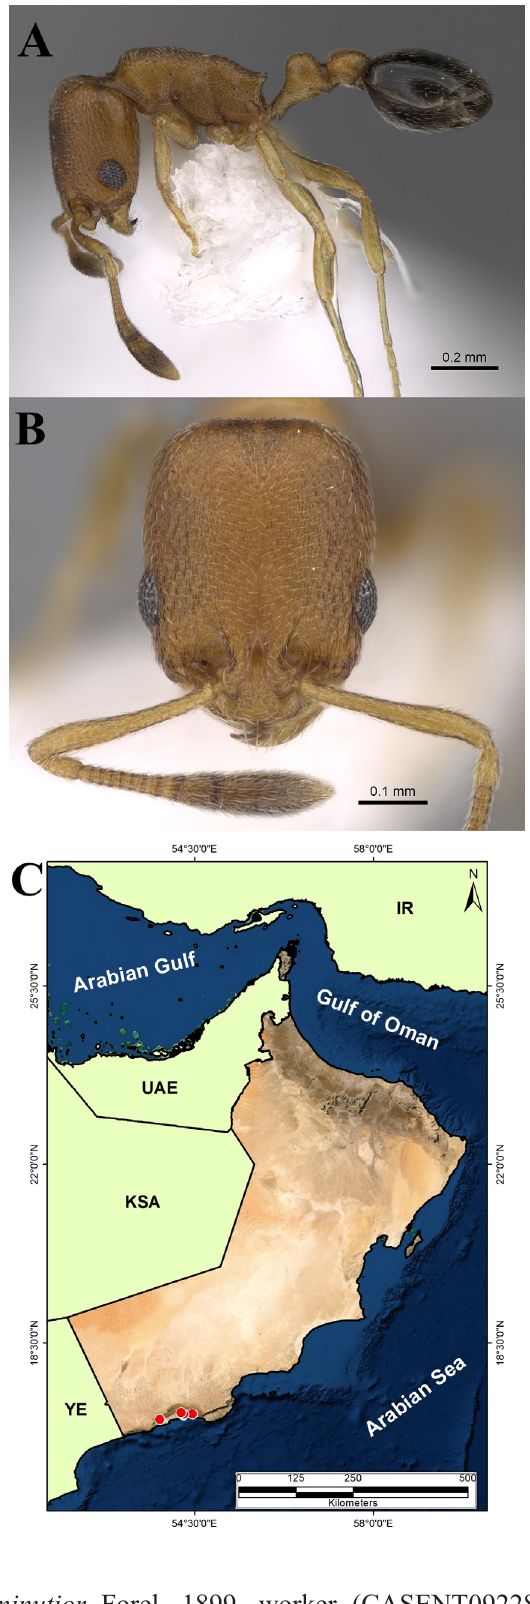
Fig. 26. Cardiocondyla minutior Forel, 1899, worker (CASENT0922873, AntWeb.org (Michele Esposito)). A . Body in profile. B . Head in full-face view. C . Distribution